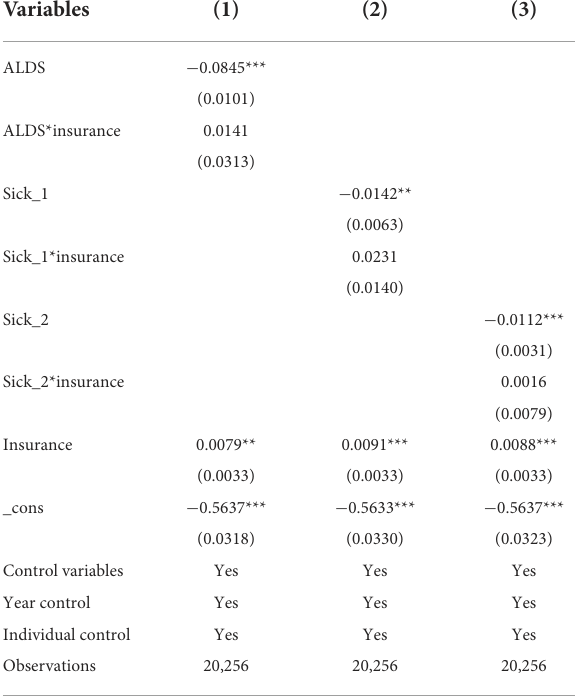
TABLE 7 Results of mediating effect of basic medical